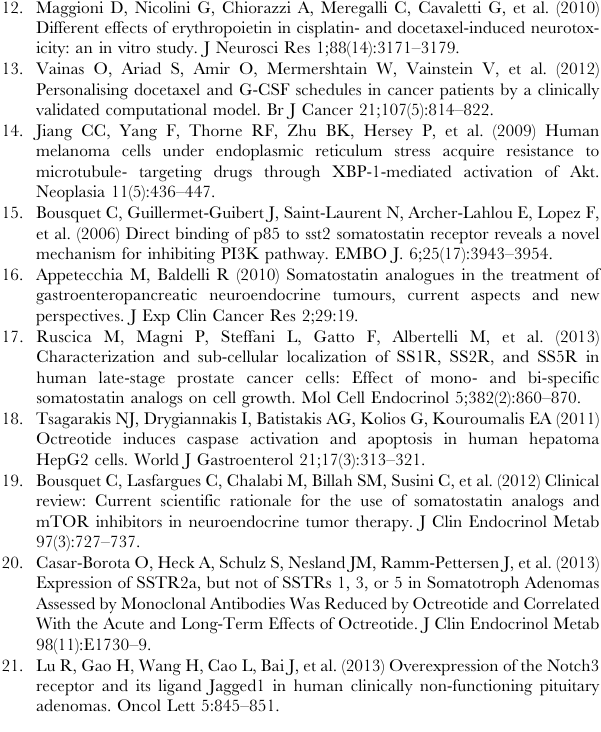
with untreated cells (mean 6 SEM of three experiments done in triplicate). (**) Proliferation was significantly decreased ( p , 0.001); error bars = SEM. (TIF) Figure S3 Effects of DTX alone, OCT alone and the combination of DTX/OCT on the expression of VEGFA, caspase 9, caspase 3 and ABCB1 in DU145 cells by qRT– PCR respectively, using cells following 48 h of treat- ment. The expression level of each mRNA was normalized to the level of b -actin. Values represent the means 6 SD of triplicate analyses (* p , 0.05, ** p , 0.01). (TIF) Figure S4 Detection of caspase 3, and caspase 9 expression in DU145 cells by western blot (A). Results show that significantly increased caspase 3 and caspase 9 expression levels in DTX alone and in combination with OCT following 48 h treatment. (B) Densitometric analysis was per- formed using Kodak one-dimensional image analysis software. (p , 0.01). (TIF) Figure S5 Growth curves of prostate cancer xenograft PC3 (A) and DU145 (B) in control mice, castrated mice and mice treated with docetaxel including two groups of 10 mg/kg and 20 mg/kg docetaxel treatment. Tumor measurement starts from the drug treatment (p , 0.015). (n=